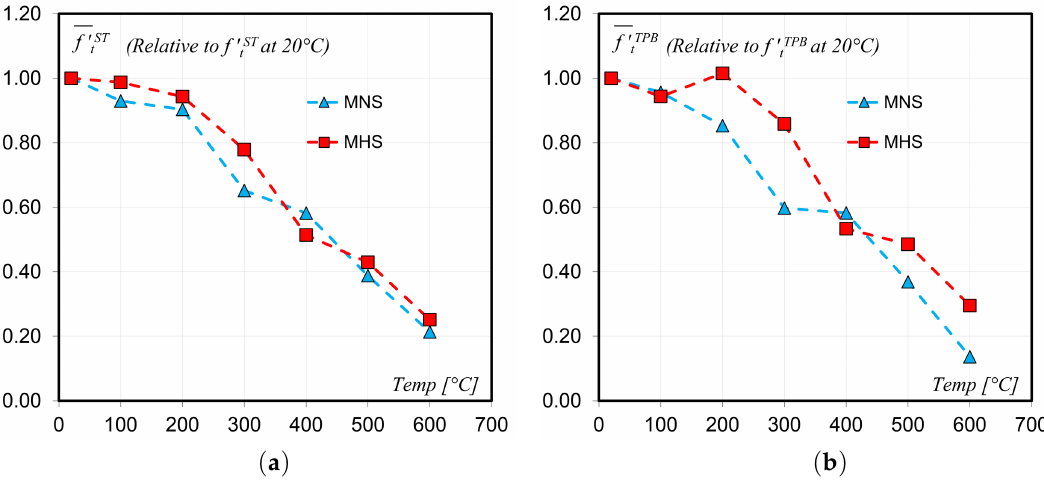
Figure 10. Evolution of indirect tensile strength with temperature corresponding to: ( a ) ST (Splitting Tensile tests) and ( b ) TPB (Three-Points Bending tests). Relative values with respect to the reference tensile strength at 20 ◦